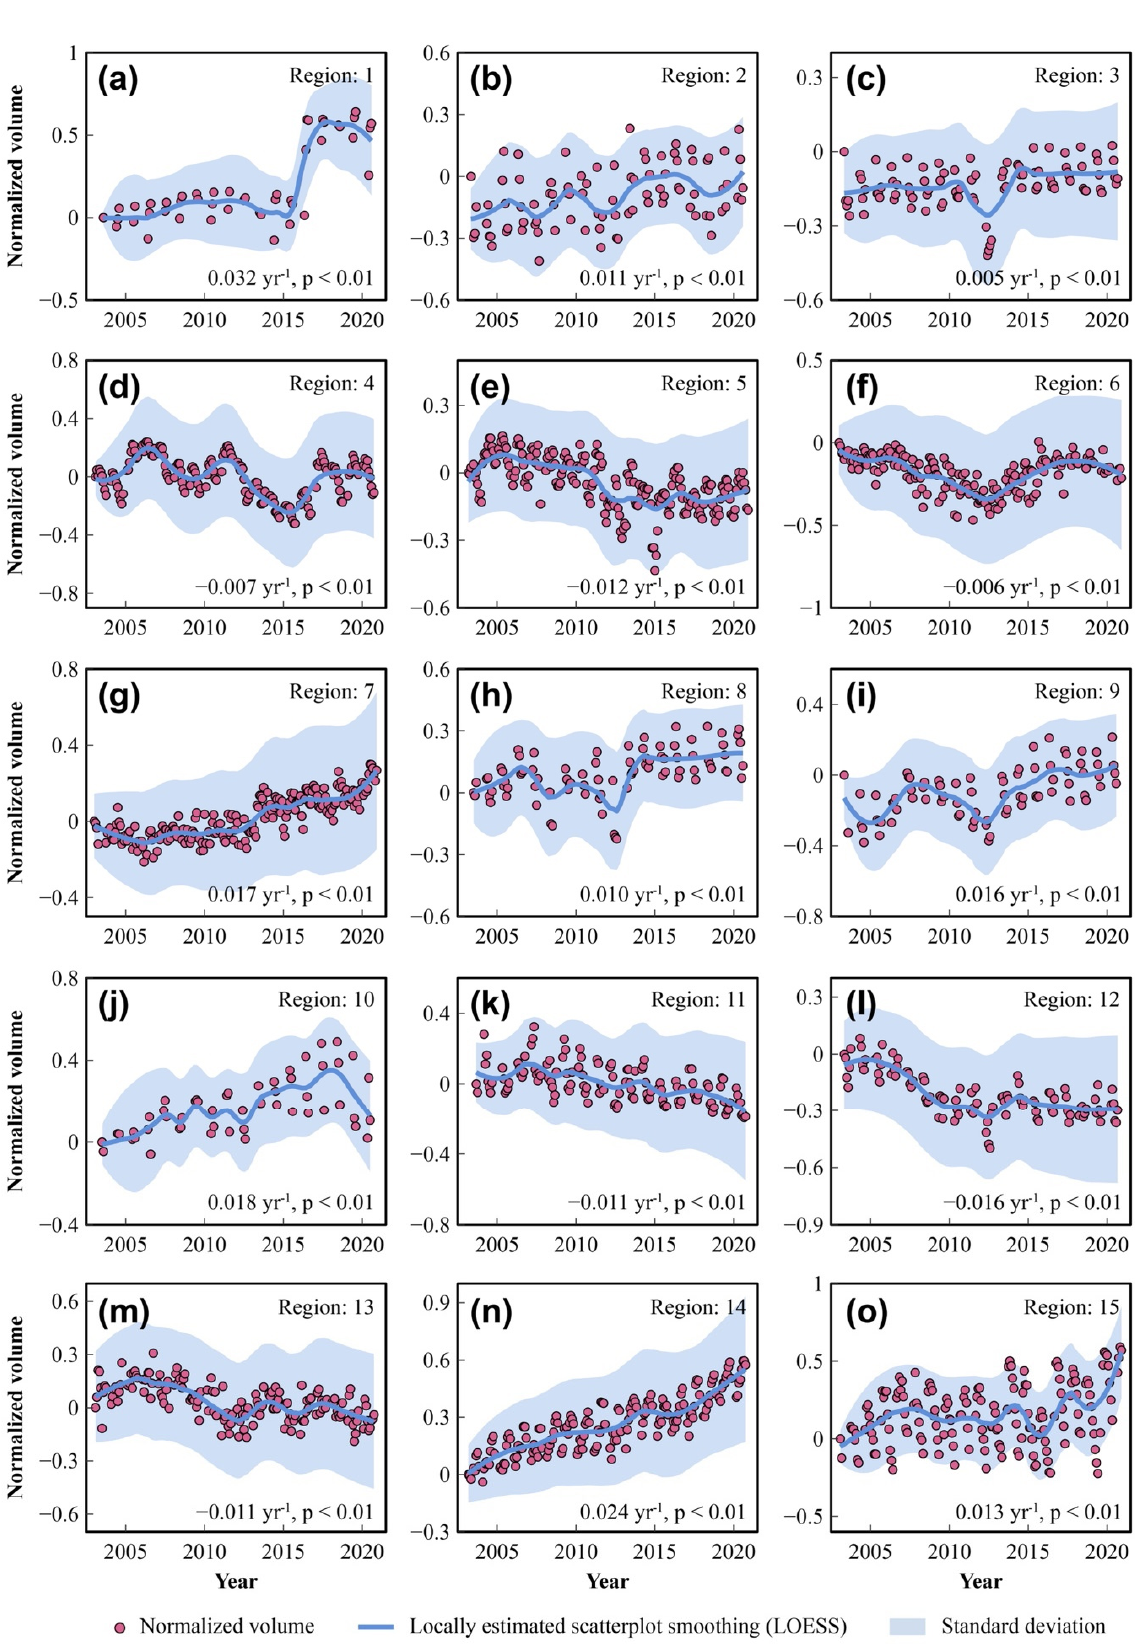
Figure 3. Time series of normalized lake volume in the period of 2003–2020 for the 15 hot spots ( a – o ) of lake change. The locations of the hot spots are shown in Figure 2b. In each panel, red dots represent the monthly normalized lake volumes of a region (mean across all lakes, with the nor- malized volume of each lake in this region calculated using Equation (12)). A trend line is shown in blue and was calculated using the locally estimated scatterplot smoothing (LOESS) method. The